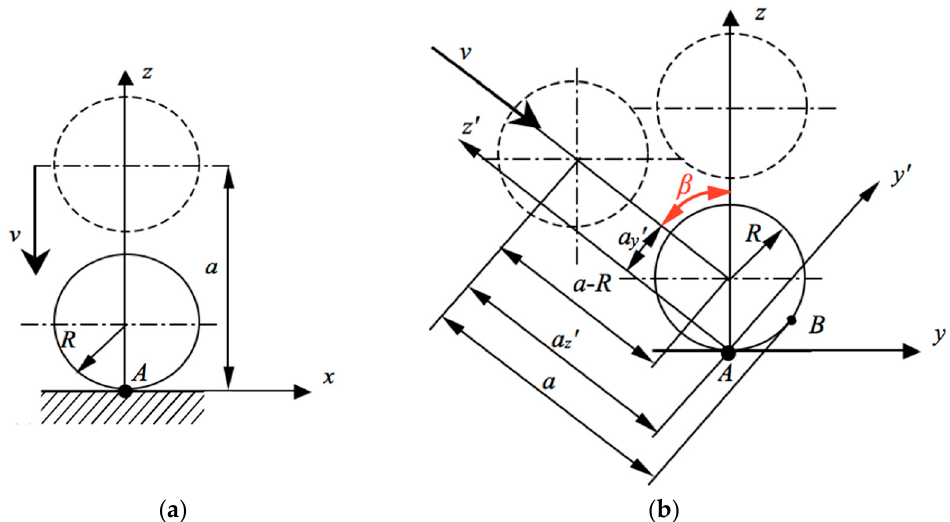
Figure 2. Contact point A between the ball tip and the measured surface: ( a ) Basic coordinate system oxyz for the identification of contact point A ; ( b ) Coordinate system after the rotation of the local coordinate system by angle β .